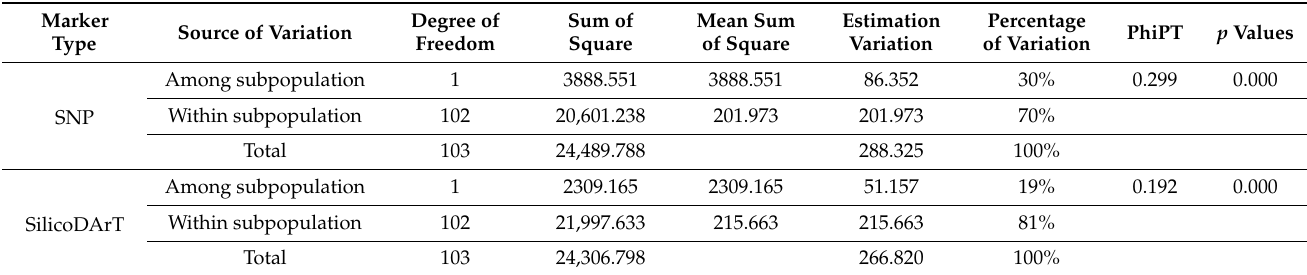
Table 3. Analysis of molecular variance (AMOVA) of the genetic variation among and within the of Rhodes grass subpopulations collection using high throughput DArTSeq markers.